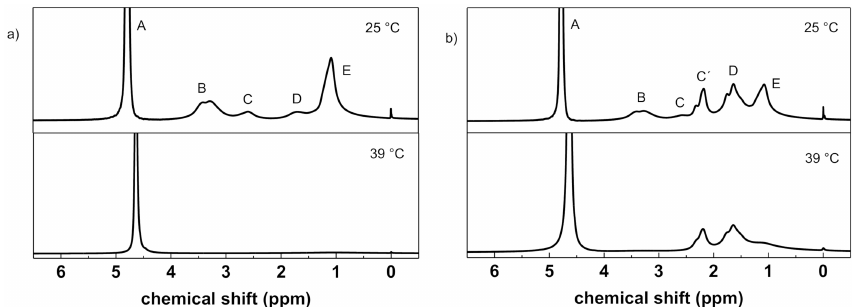
Figure 6. 500.1 MHz 1 H spectra of hydrogels ( a ) SN1 and ( b ) DNA1 in D 2 O recorded at 25 ◦ C and 39 ◦ C under the same instrumental conditions. Peak assignments are explained in the text.